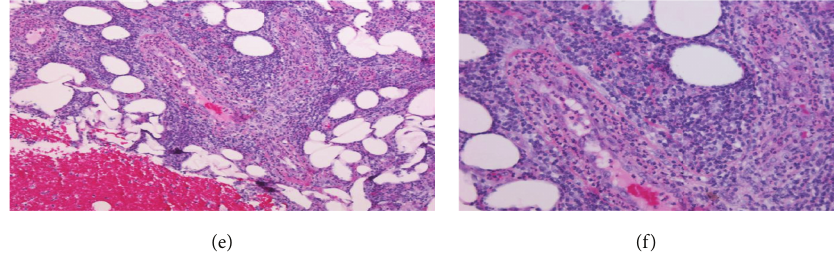
Figure 4: (e) (10x) and (f) (20x) Vessels in the deep dermis and subcutis are infiltrated by neutrophils and have fibrin in their